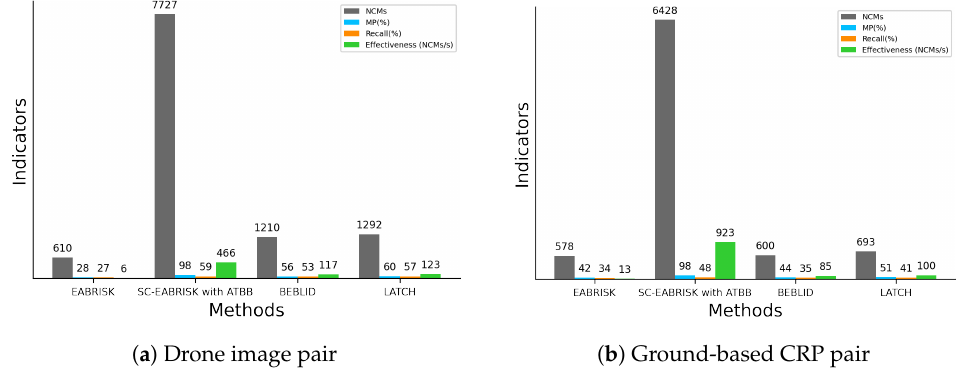
Figure 9. Numerical analyses of the image matching results obtained with